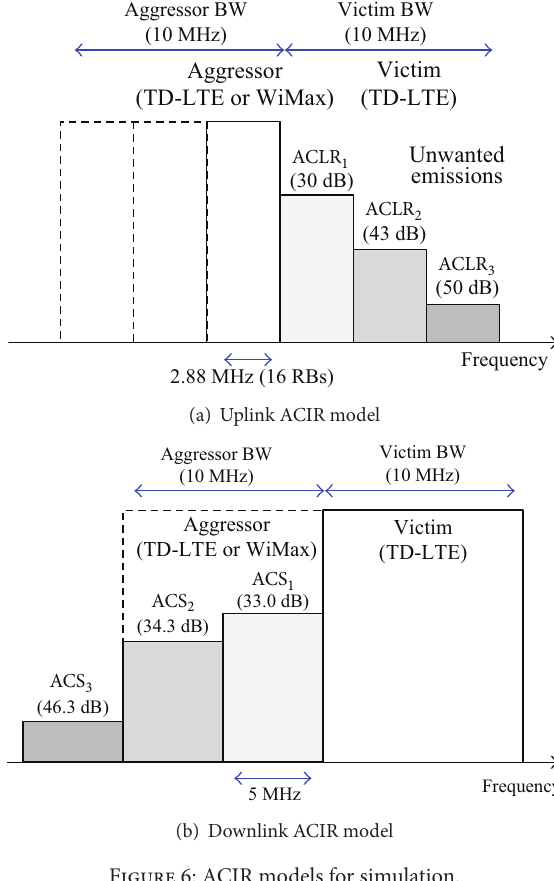
Figure 6: ACIR models for simulation. Table 6: TPC parameters for TPC sets 1 and